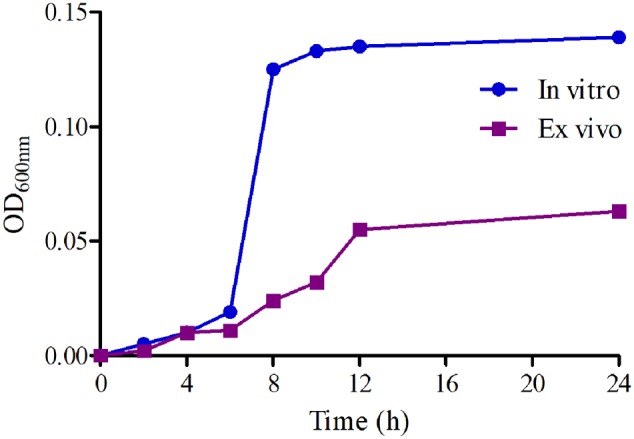
The growth-time curves of HB2 in TSB and serum.